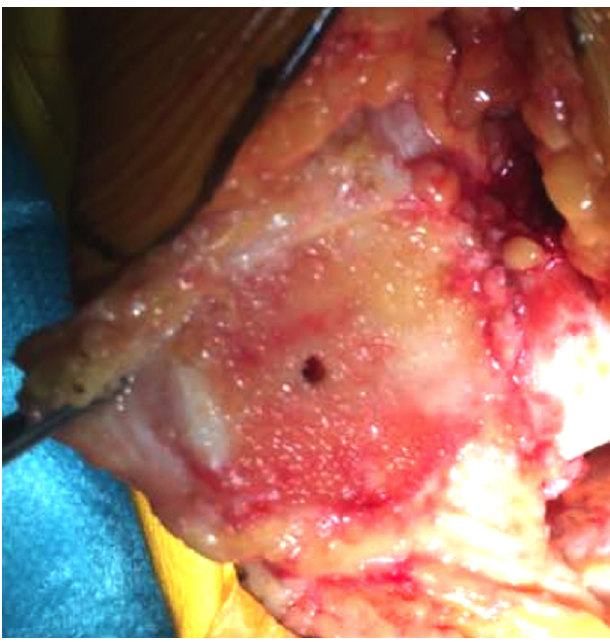
Figure 6. Pre-drilled hole identi fi ed on the patellar remaining cut.